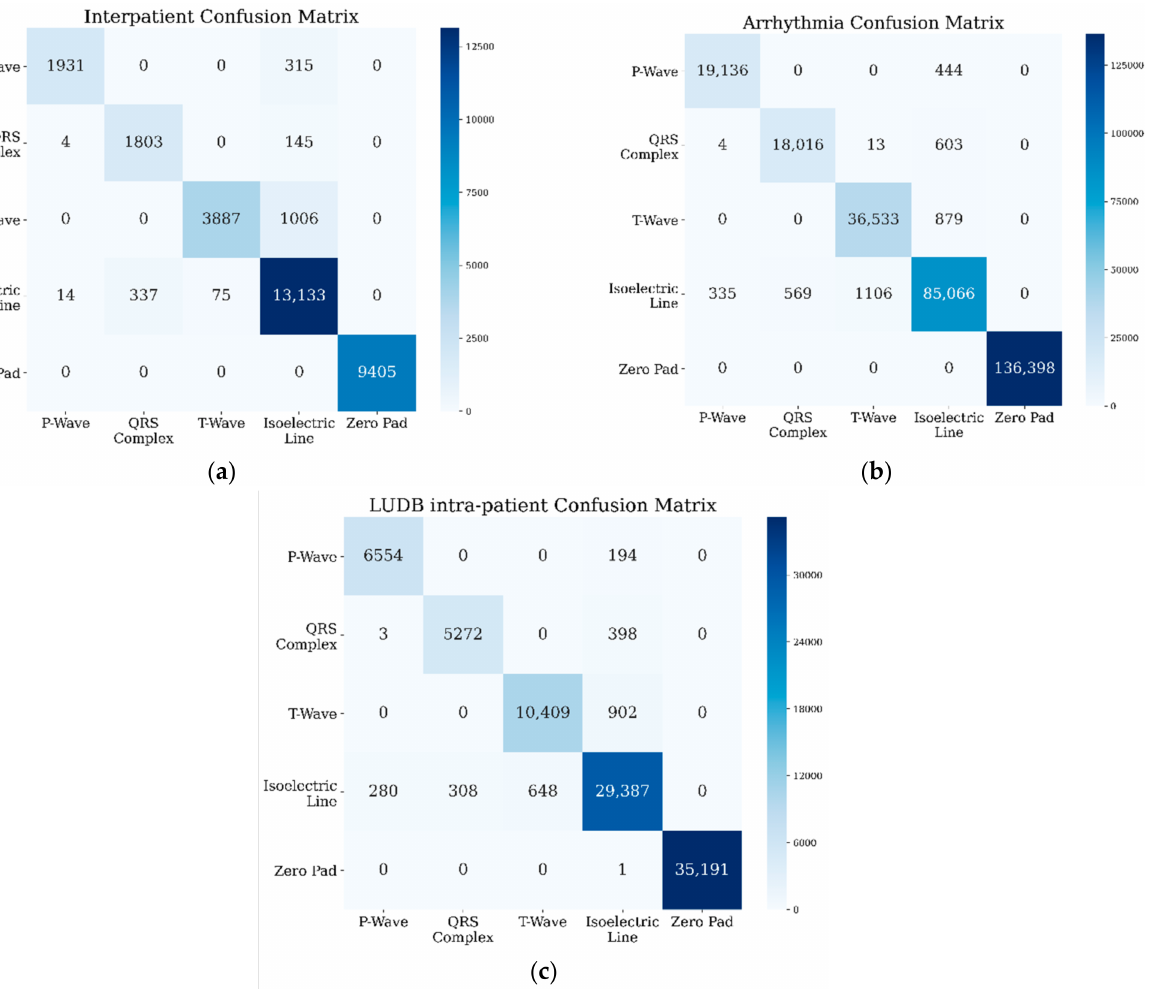
Figure 6. Confusion matrices for QTDB’s ( a ) inter-patient and ( b ) arrhythmia conditions, and ( c ) LUDB’s